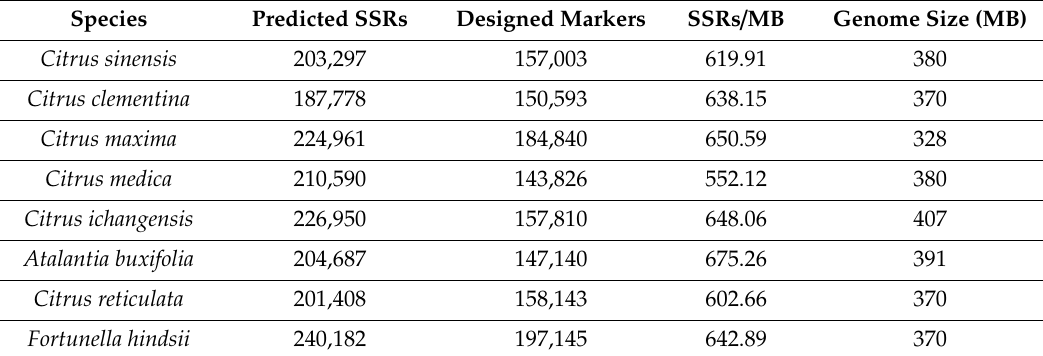
Table 2. Distribution of identified SSRs in Citrus species.